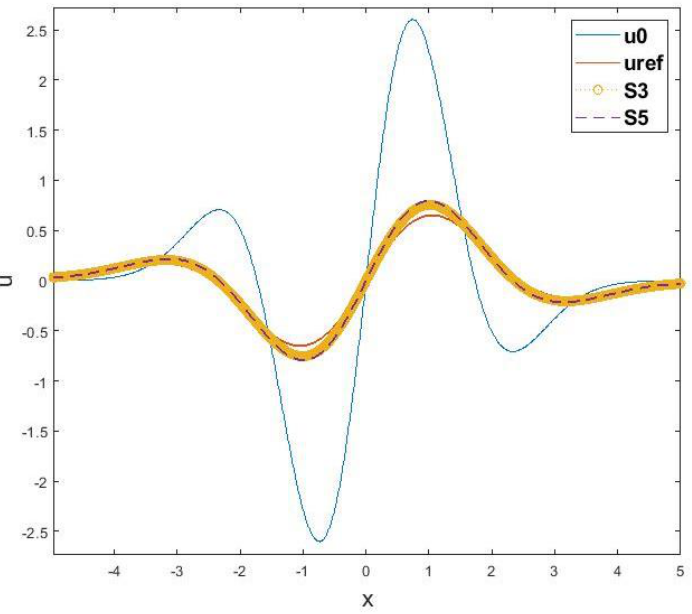
( , ) u x t and uref is the 4 2 10 h    .